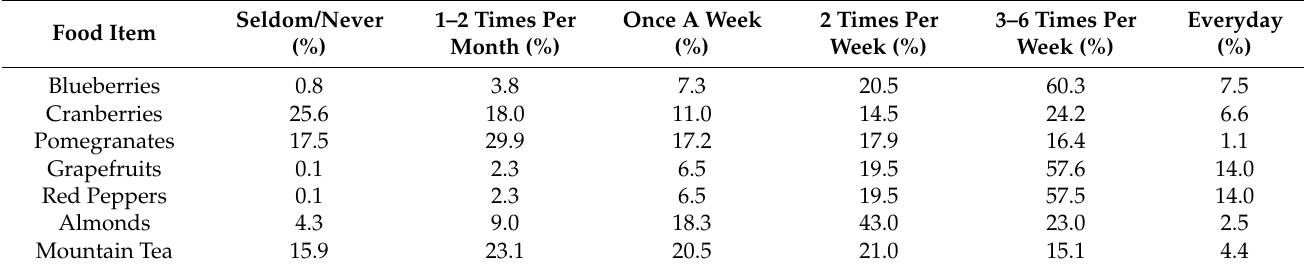
Table 3. Frequency of consumption of blueberries, cranberries, pomegranates, grapefruits, red peppers, almonds, and mountain tea by the